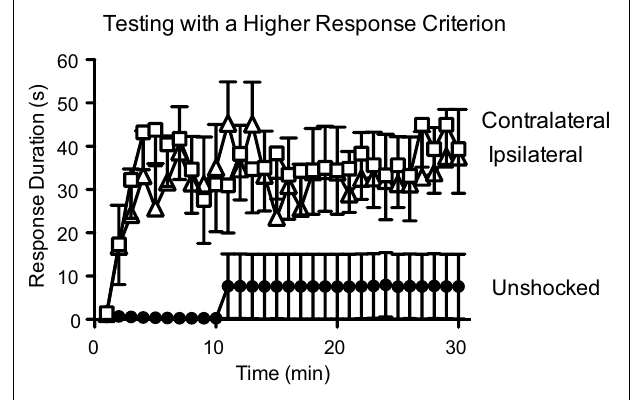
FIGURE 6 | Prior training with controllable shock enables learning. Spinally transected rats received instrumental training using a moderate (4mm contact electrode depth) and were then tested with response-contingent shock applied to the pretrained (ipsilateral) or opposite (contralateral) leg. Prior to testing, the task was made more difficult by raising the response criterion to an electrode depth of 8mm. Under these conditions, previously untrained rats (Unshocked) failed to learn. Rats that had received instrumental training were able to learn and this was true irrespective of whether they were tested on the ipsilateral or contralateral leg. Adapted from Crown et al.